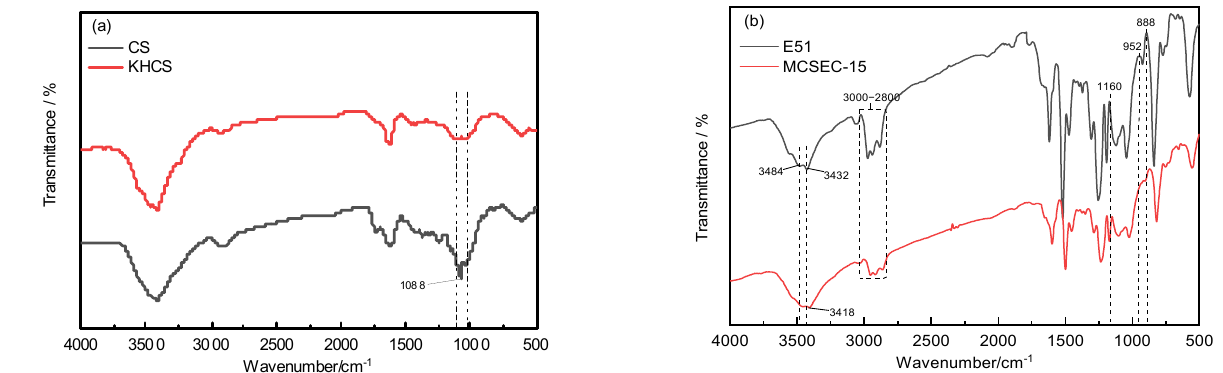
Figure 1. FT-IR spectra ( a ) CS and KHCS; ( b ) curing systems: pure E51 and MCSEC-15. The mechanism of CS modified with KH560 is shown in Scheme 1. The CS was composed of cellulose, hemicellulose, and lignin. The hemicellulose had dissolved during the pretreating process, and lignin could not react under the reaction condition in this study. Thus, the silane coupling agent was hydrolyzed to silanol functional groups, which increased the number of functional groups and improved the chemical activity. The hydroxyl group of silanol was then reacted with the hydroxyl group at position 6 of cellulose to obtain KHCS [28,29].